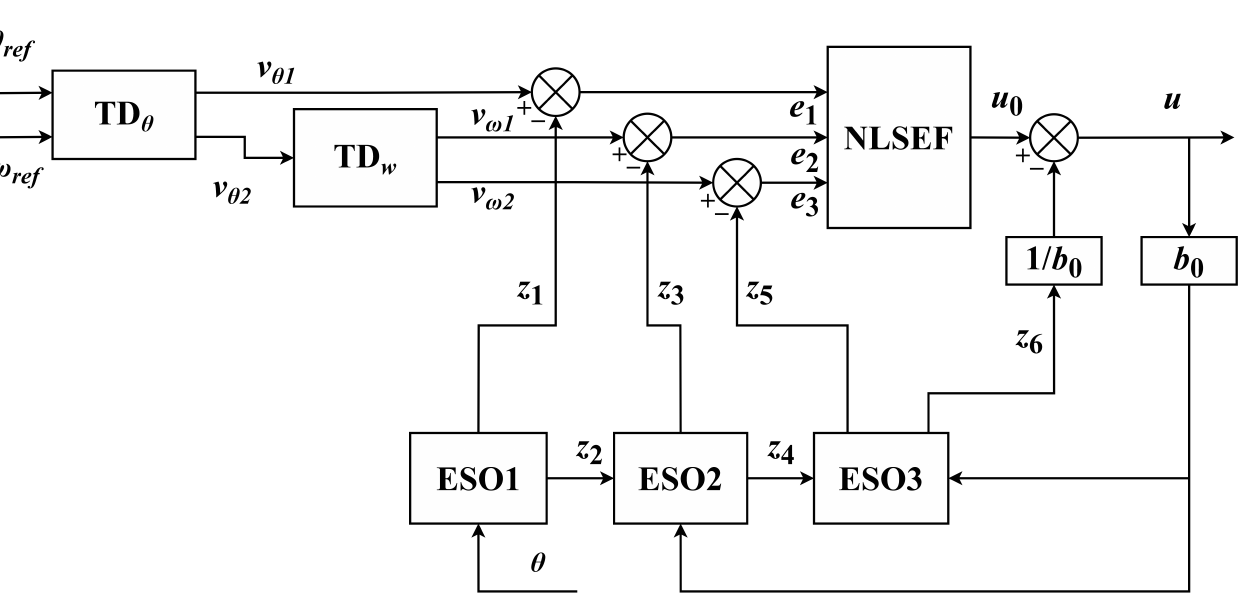
Figure 1. The principle block diagram of the improved